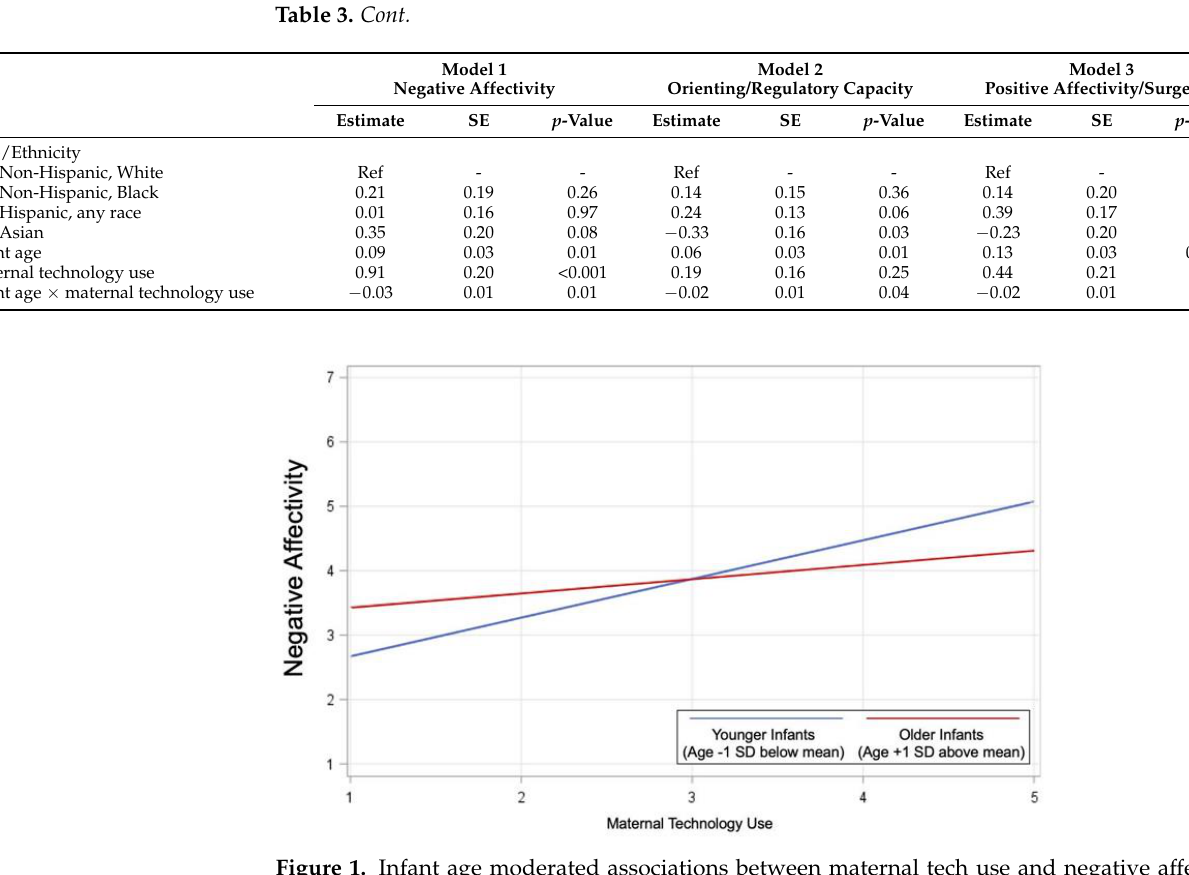
Figure 1. Infant age moderated associations between maternal tech use and negative affectivity ( p = 0.01). The positive association between increased frequency of maternal tech use and infant negative affectivity was significantly stronger for younger infants (age −1 SD below average; p < 0.001) than for older infants (age +1 SD above average; p = 0.03).